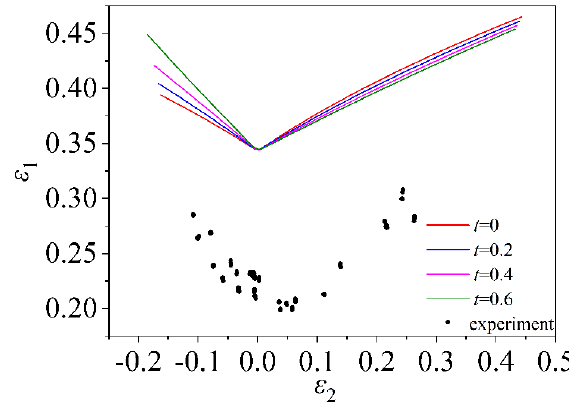
Figure 24. FLD of material AA5182 based on Swift constitutive equation and MMFC instability cri- terion.